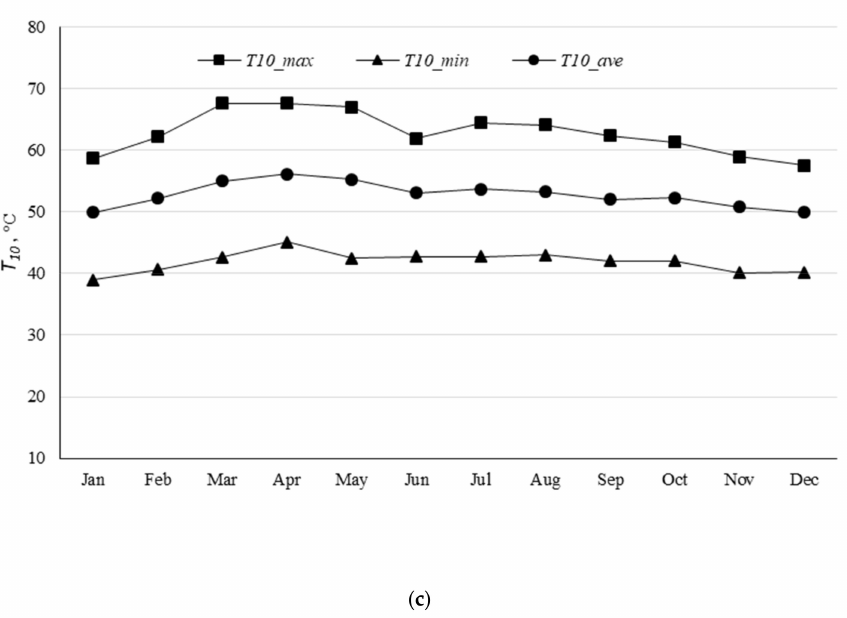
Figure 10. Maximum, minimum, and average drying temperature T 10 . ( a ) Mode 1; ( b ) Mode 2; ( c ) Mode 3.